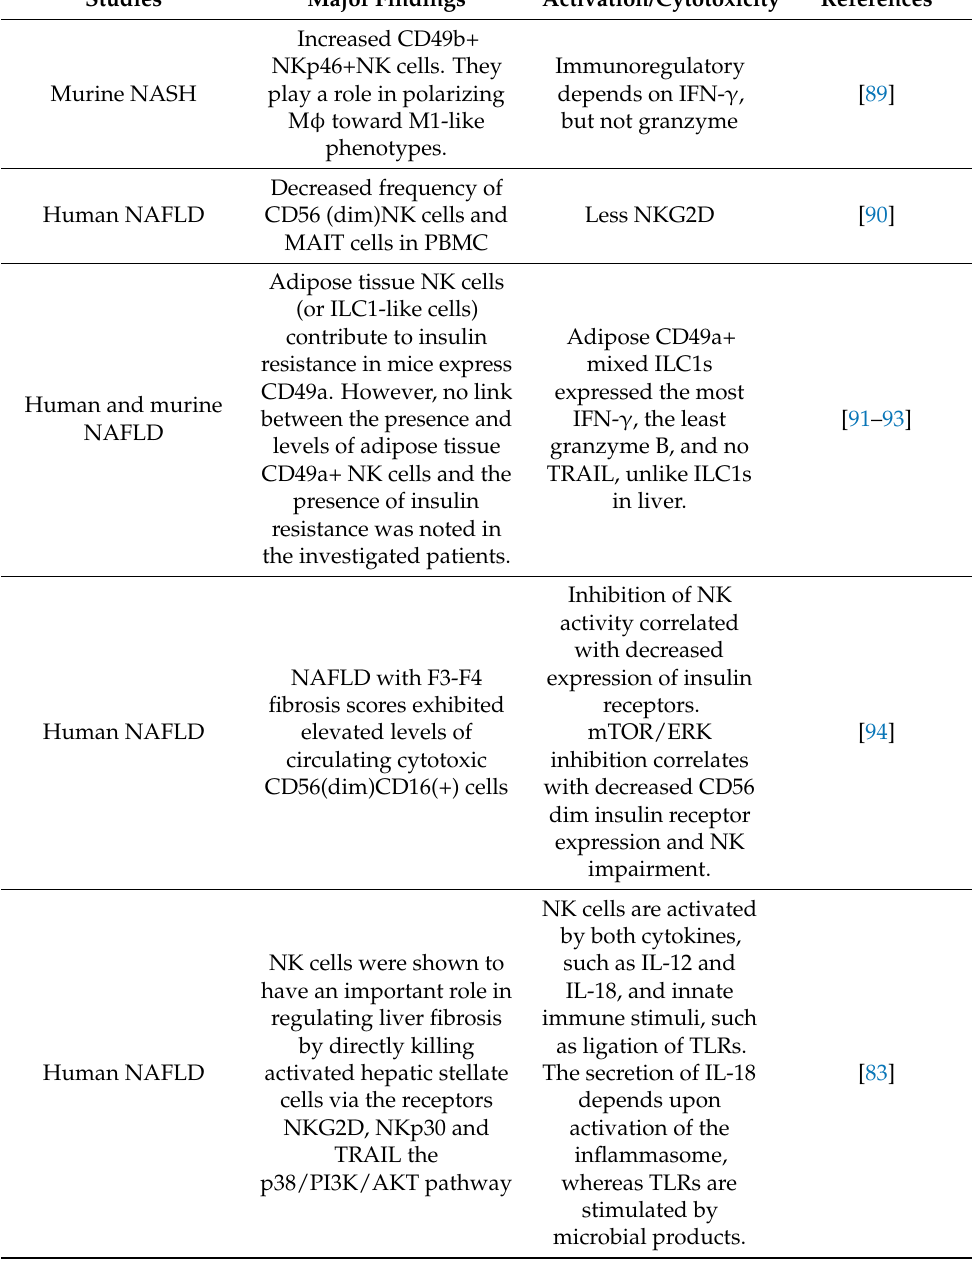
Table 2. Summary of NK cell subsets in non-alcoholic fatty liver